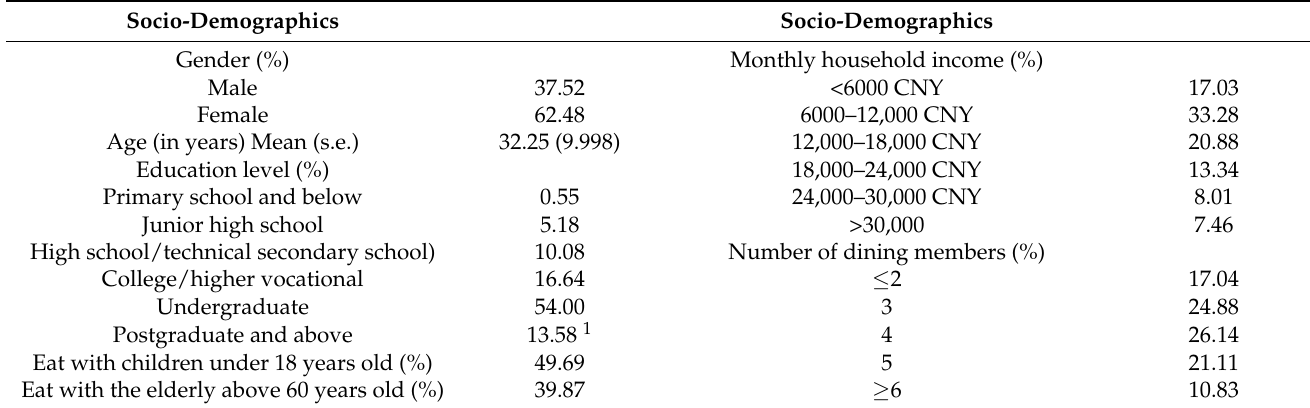
Table 2. Some socio-demographic characteristics of respondents ( n = 1274).